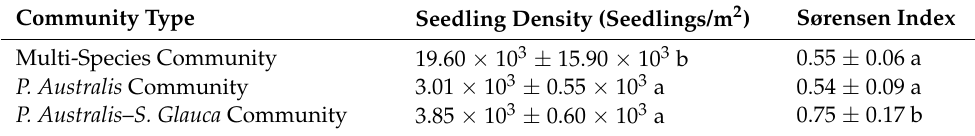
Table 4. Seedling density in the seed banks of the three dominant vegetation communities in the YRD.